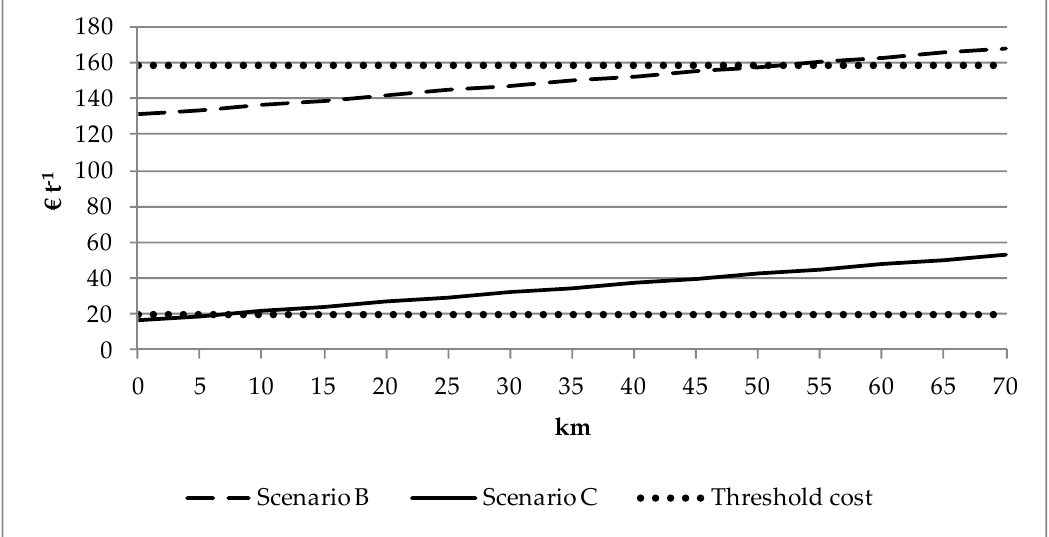
Figure 6. Trend of the production cost including transport in Scenario B (dashed line) and Scenario C (solid line). The crosses with the dotted line indicate the threshold distance of convenience, referring to a minimum profit margin of 30 € t − 1 .